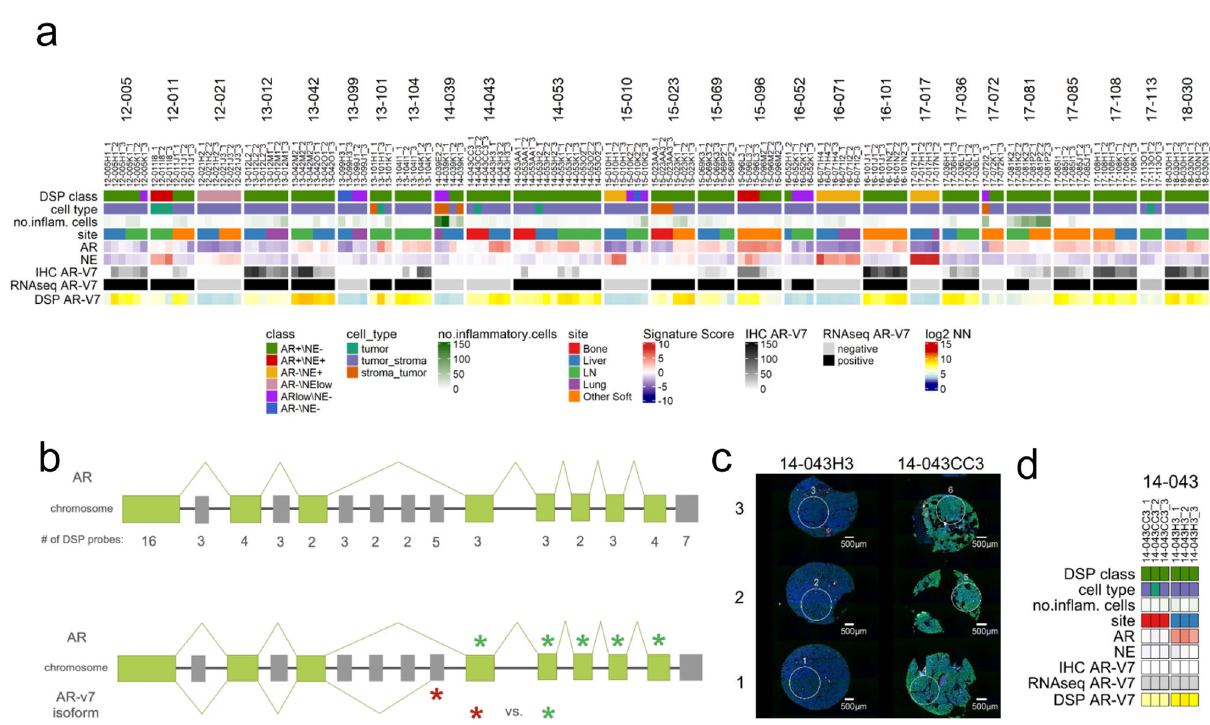
Fig. 6 Alternative splicing of AR isoforms is present across metastases, as determined by DSP. a Heatmap of 141 individual tumor ROIs grouped by 26 patients comparing bulk RNAseq AR-V7 expression to DSP. Results are expressed as gene signature Z -scores and log 2 negative-normalized (NN) gene expression and presented according to color scales. b DSP – RNA probe design of AR full length and AR-V7 variant isoform. c Fluorescent labeling and ROI selection of three cores from two sites of metastasis from patients 14-043 that demonstrated divergent AR-V7 expression determined by RNAseq and DSP. N = 1 TMA section for fl uorescent labeling. d Heatmap demonstrating discordance in AR-V7 expression DSP AR-V7 and AR-V7 measured by bulk RNAseq and AR-V7 immunohistochemistry (IHC) in six tumor ROIs from two sites (CC3 and H3) within patient 14-043. Results are presented according to color scales in a